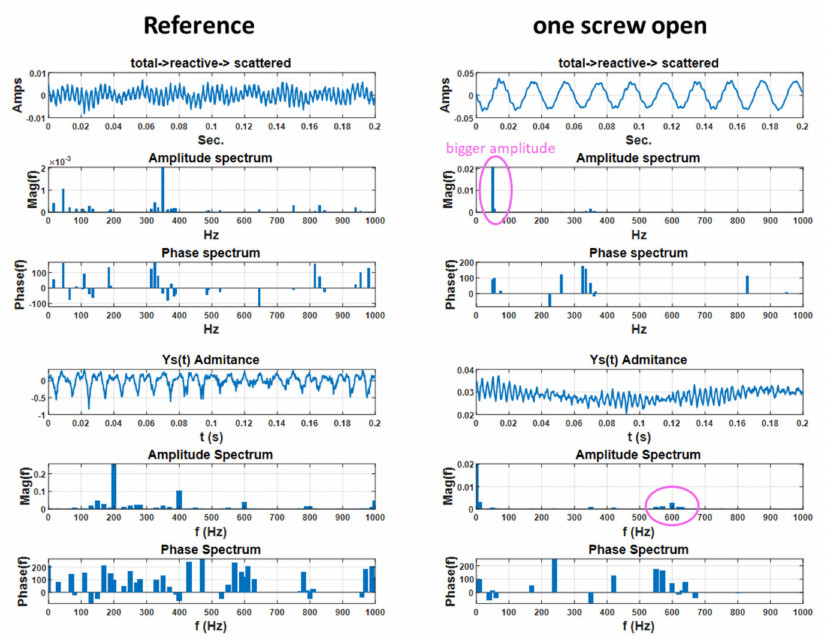
Figure 18. Reactive → scattered current and admittance spectra, all screws closed vs. one screw mildly